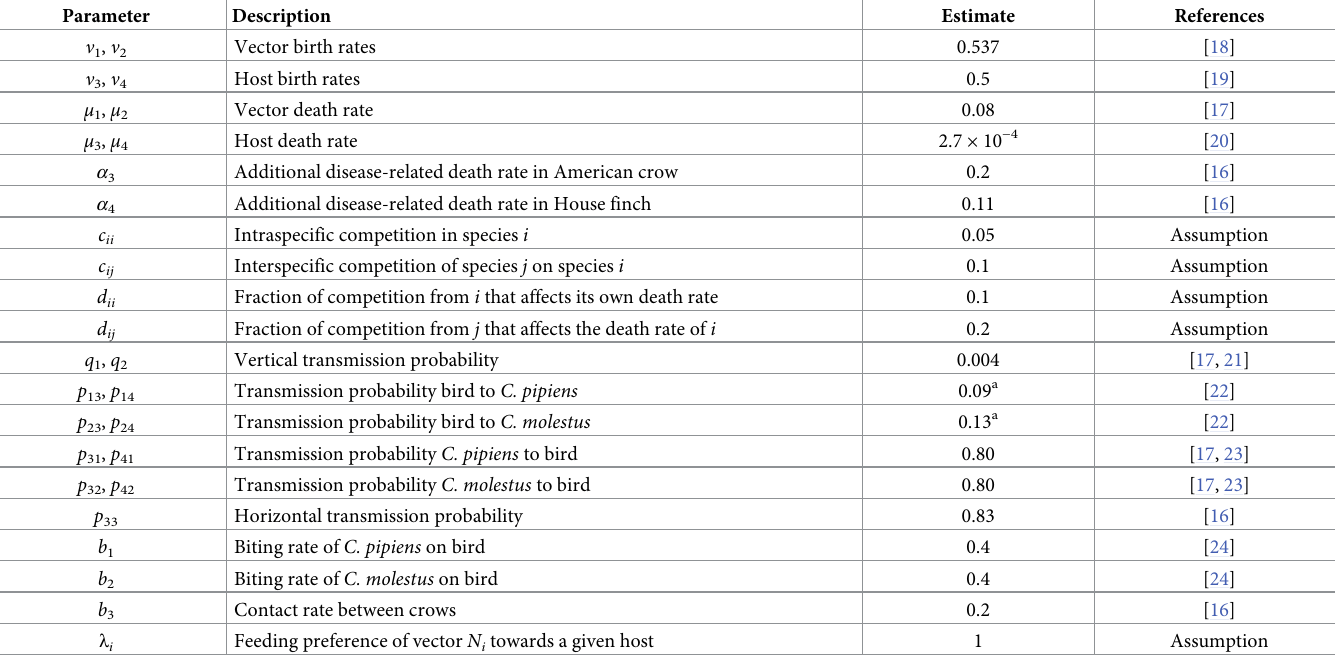
Table 1. Parameter definitions and values used in the numerical simulations. All rates shown are per day. The competition coefficients c are varied in the numerical simulations and otherwise fixed to these default values. Parameter